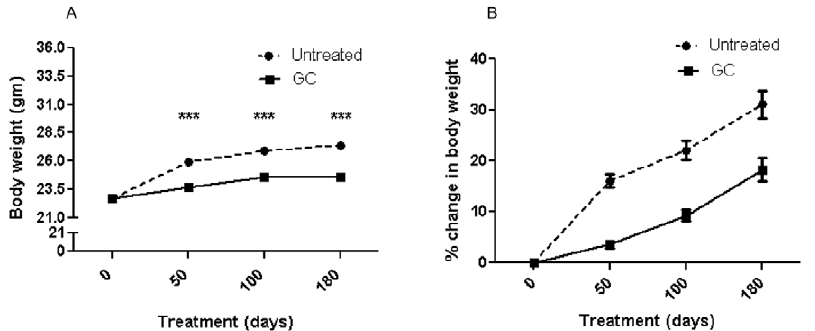
Figure 1. Effect of treatments on body weight. ( A ) mdx mice received no treatment (N=84, 83, and 44) or GC treatment (N=92, 89, and 38) for 50, 100, or 180 days, respectively, *** p= , 0.001. ( B ) Comparison of the % rate change in body weight of untreated and GC-treated mice at 50, 100, and 180 days. The rate at which body weight changed was established in the first 50 days, when the change occurred in the untreated mice at a much faster rate ( , 0.0001). The rate remained greater than that for the treated mice, but the change over time was the same for both groups. Error bars indicate mean + /- SEM.